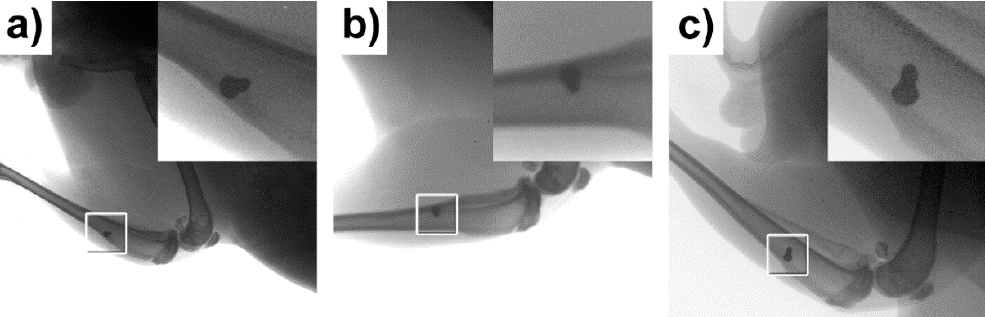
Figure 2. X-ray of the tibial bone of the three experimental rabbits 120 days after experimental screw implantation. ( a ) rabbit no. 1, ( b ) rabbit no. 2 and ( c ) rabbit no. 3. There are no osteolytic changes seen between the bones and experimental screws.